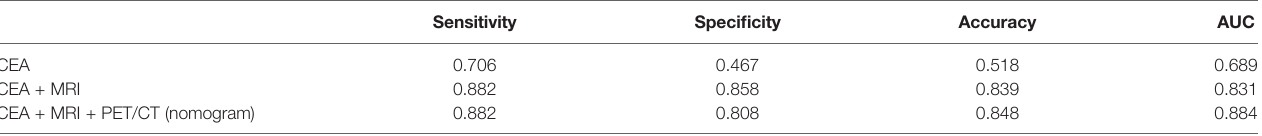
TABLE 3 | Performances of models for the training